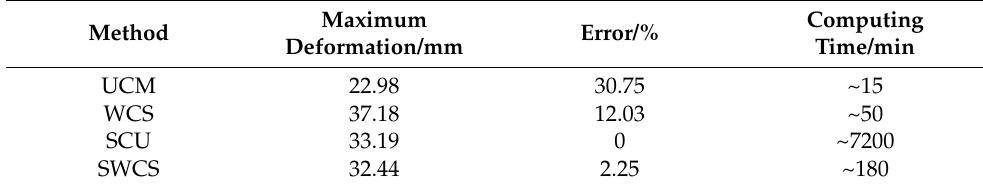
Figure 14. Variation of maximum deformation with iteration number. Table 4. Comparison of hot-to-cold analysis methods.